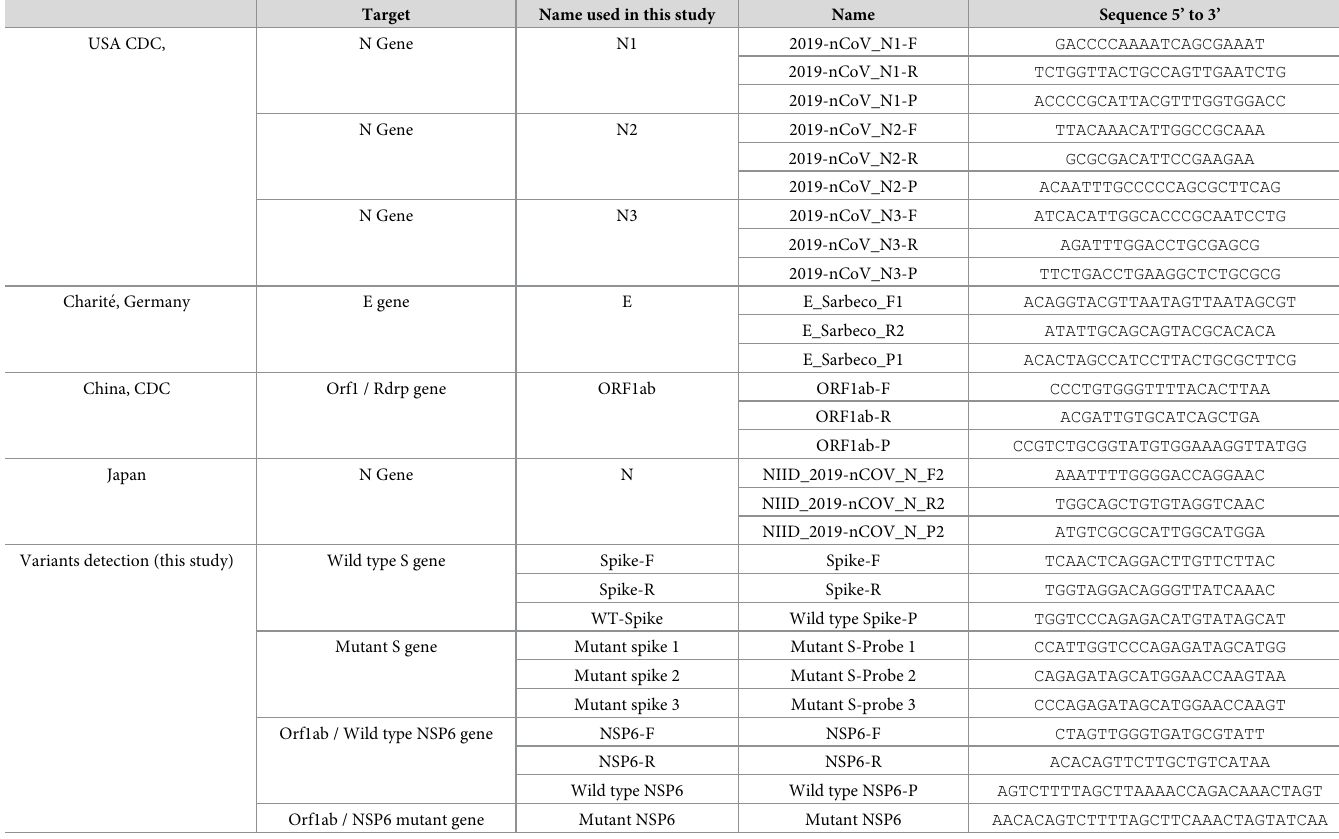
Table 1. List of primers/probe for virus